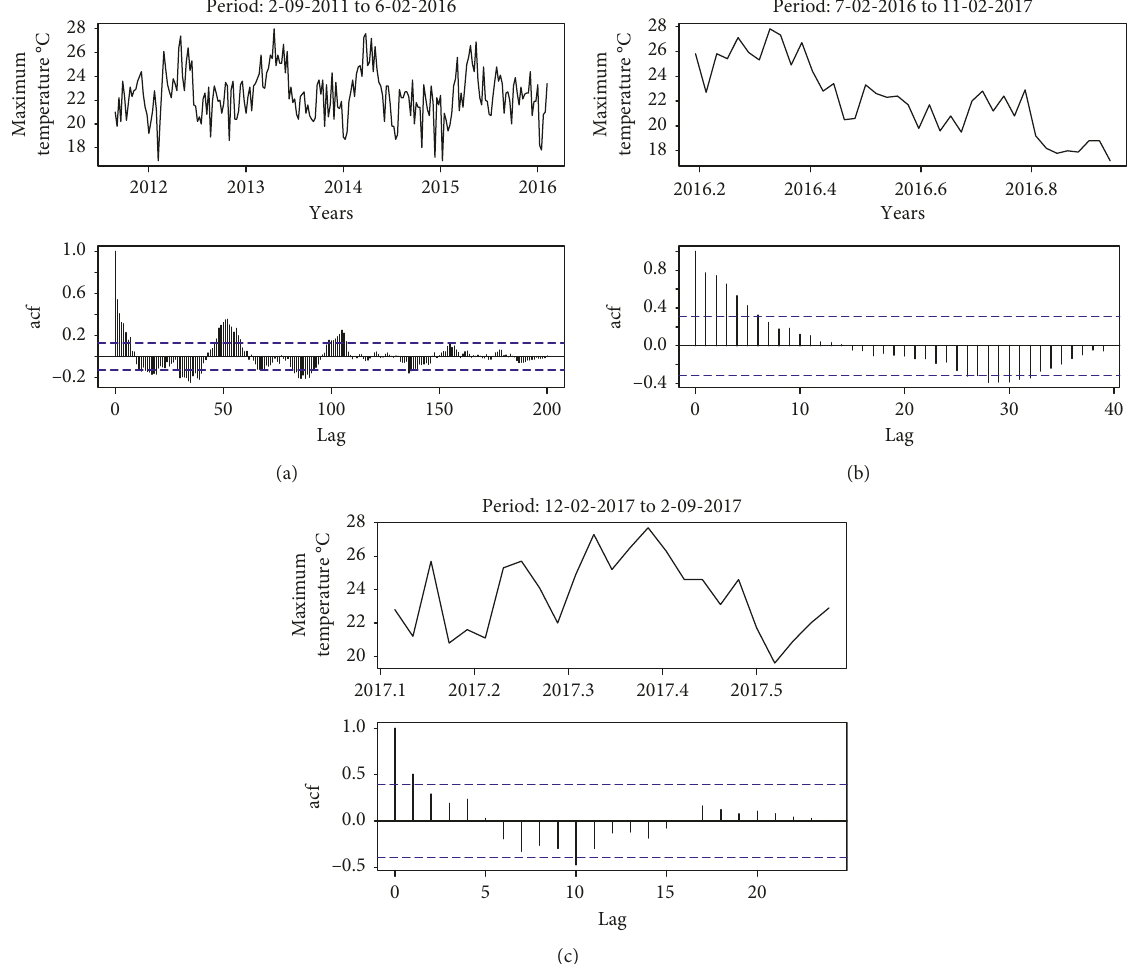
Figure 10: Partitioned time series after applying the SN method. (a) First data block. (b) Second data block. (c) Third data